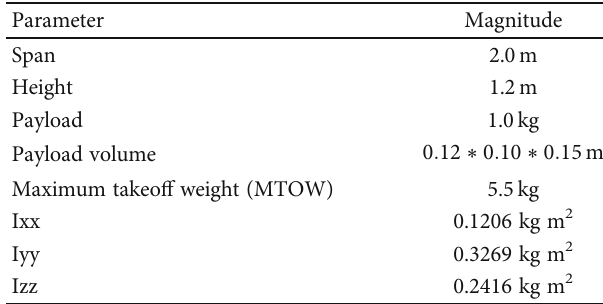
Figure 7: Indoor hovering test of the Egretta testing UAV. Table 3: Basic dimensions of the Egretta testing vehicle.